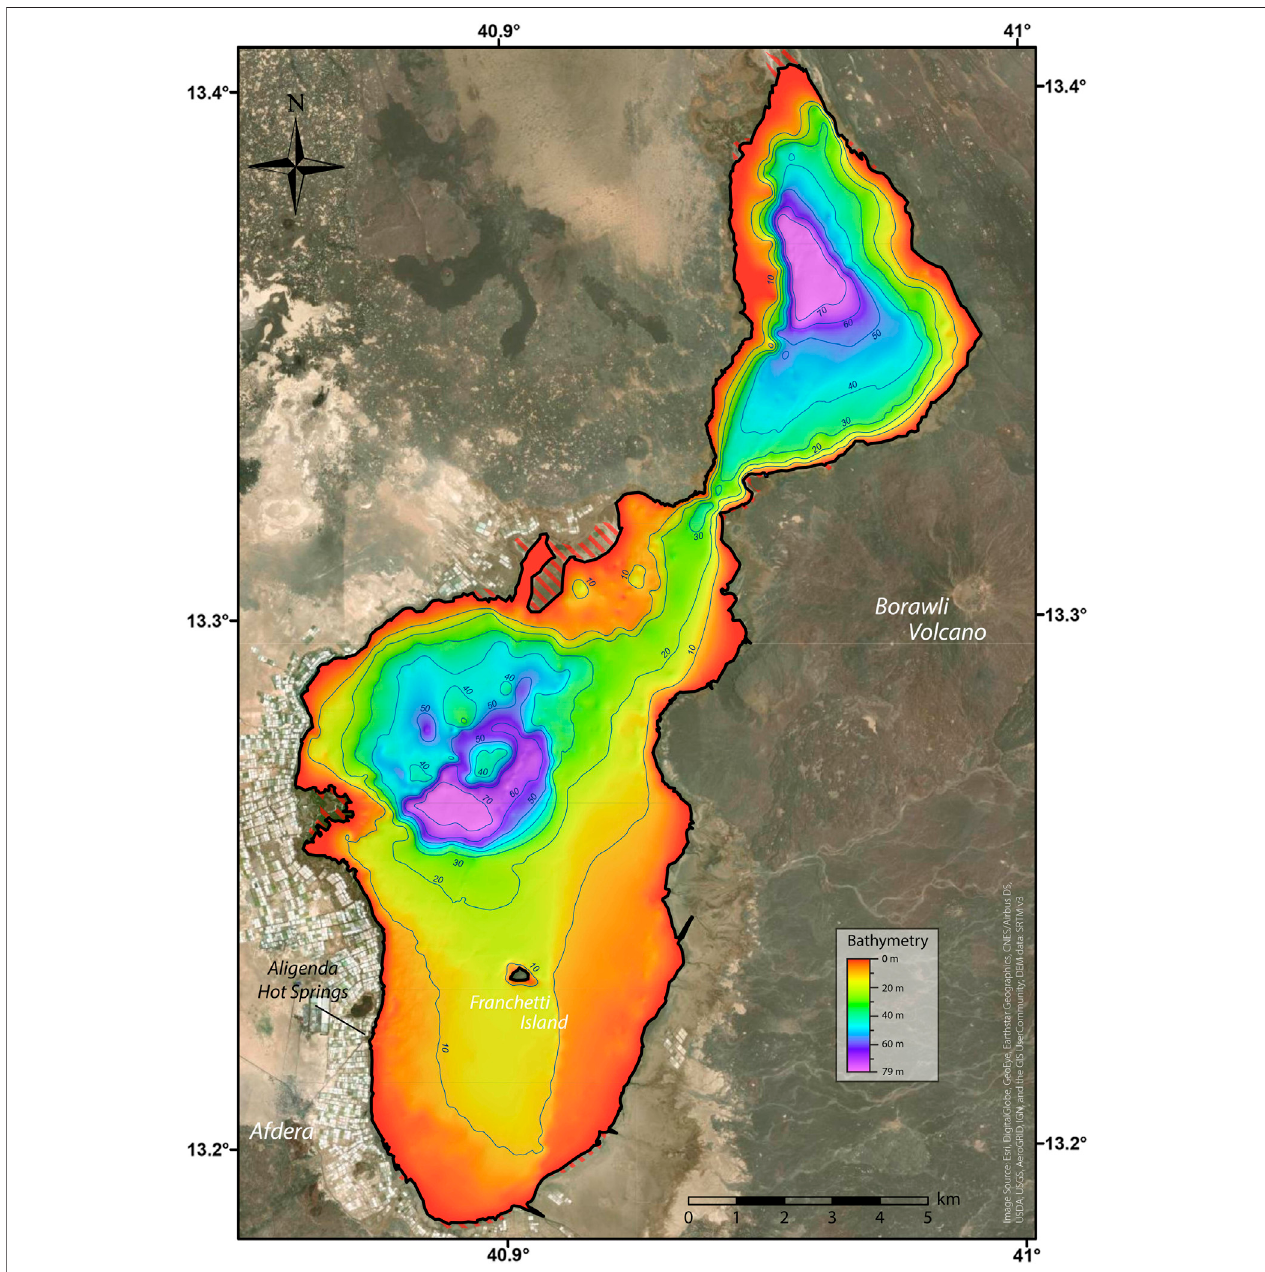
FIGURE 3 | Bathymetric map of Lake Afdera with contour lines indicating depth in meters below lake level. The deepest point of the northern basin is 80 m below thelakelevelsurfaceandthedeepestpointofthesouthernbasinis76 mbelowlakelevelsurface.Thelakesurfaceisat112 mbelowsealevel.Thered dashed surfaces indicate area periodically fl ooded by a few tens of cm of